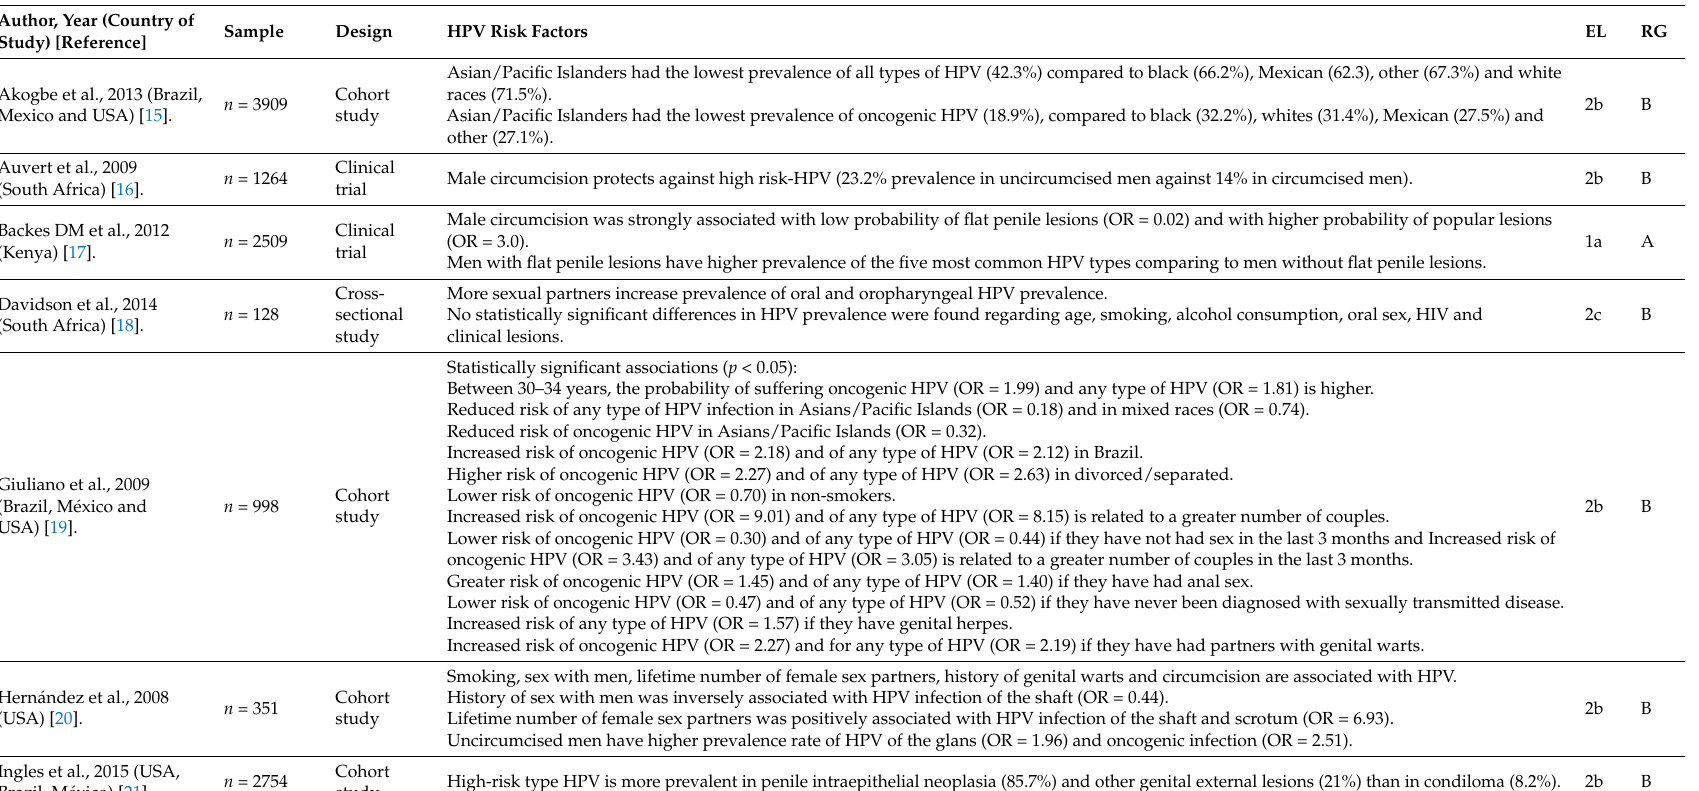
Table 1. Characteristic of included studies ( n =